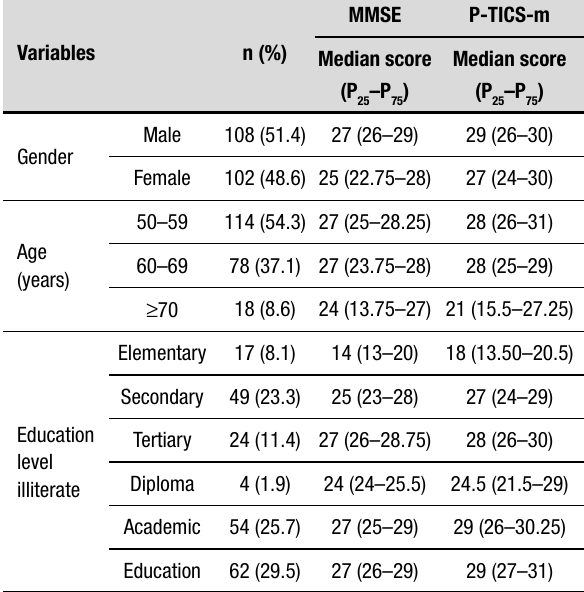
Table 1. Distribution of median and interquartile range scores of Mini- Mental State Examination and Persian version of the Telephone Interview for Cognitive Status – modified by age, sex, and education